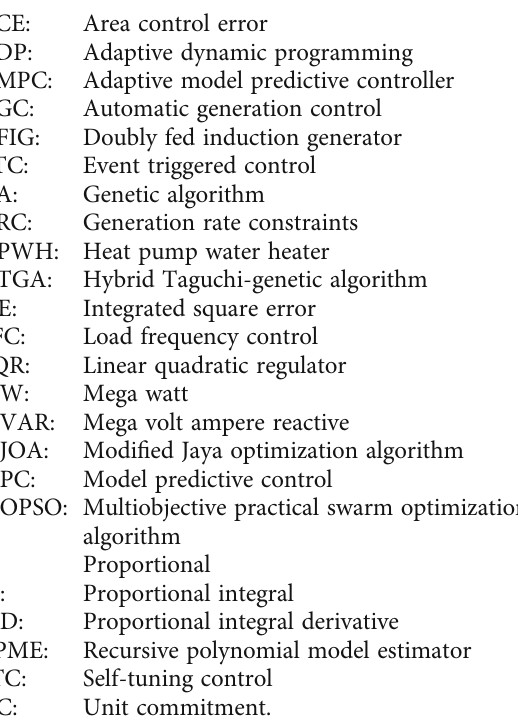
Table 4: Performance index based on